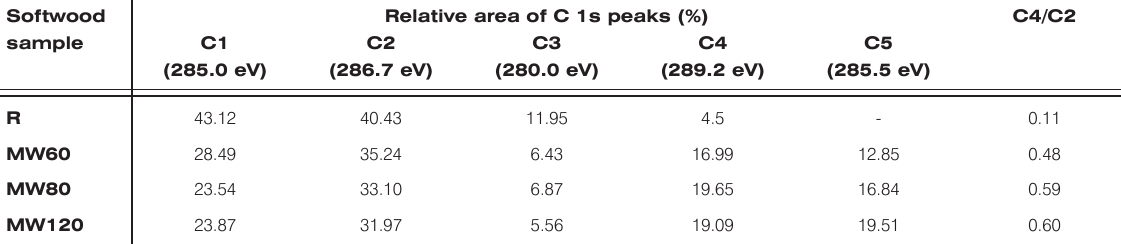
Table 4. Subpeak area fractions of C1s and ratio of C4/C2. Softwood